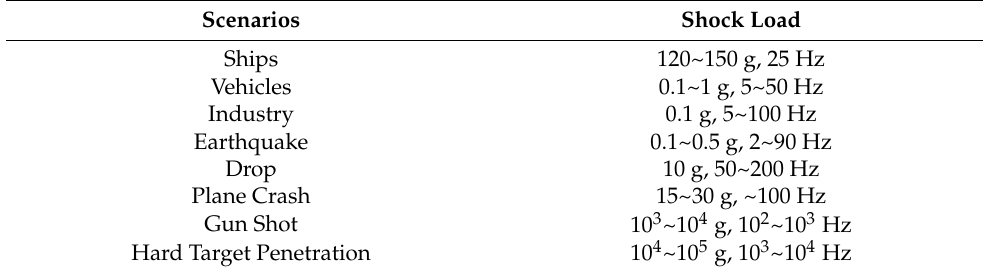
Table 1. Shock loads in different work scenarios